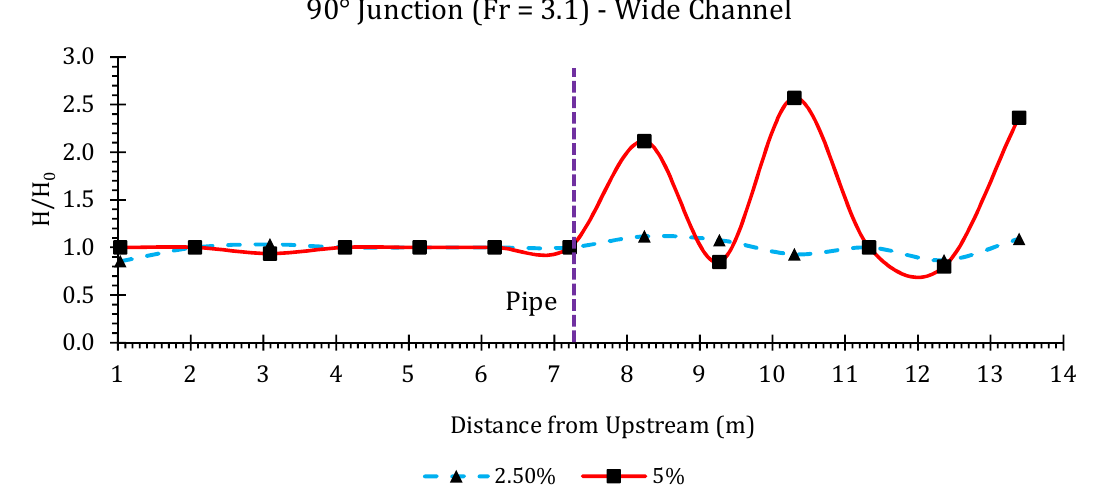
Figure A21. Water height ratios in a 90° junction for Fr = 3.1 in the wide channel.